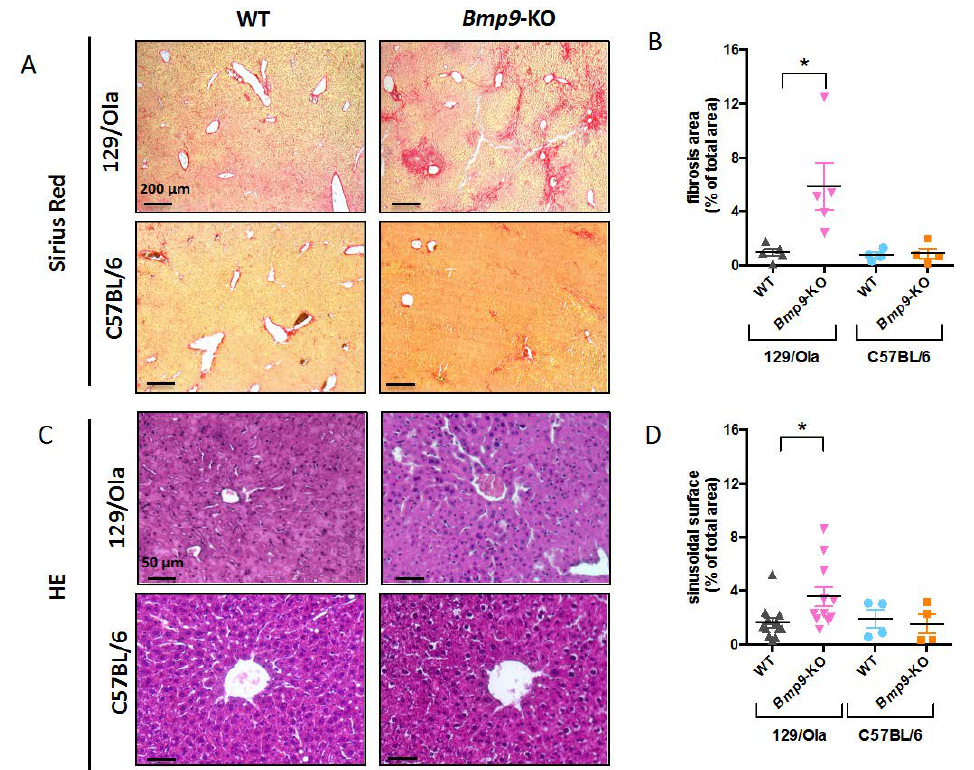
Figure 2. C57Bl/6 and 129/Ola Bmp9 -KO mice display different liver phenotypes. ( A ) Sirius red histochemical staining of the liver sections (5 µm) of WT and Bmp9 -KO mice from the 129/Ola and C57BL/6 strain. ( B ) Quantification of fibrotic surface in percentage of total area (n = 4 in each group, 5 images analyzed per mouse). Fibrotic areas appear in red and were quantified using the Axiovision software. ( C ) Hematoxylin and Eosin histochemical staining of liver sections (5 µm) from WT and Bmp9 -KO mice from 129/Ola and C57BL/6 strain. ( D ) Quantification of sinusoidal surface measured using Axiovision software and expressed as percentage of total area (n = 4–12 mice per group, 5 images analyzed per mouse). Central veins and arteries were excluded from this quantification. Data are expressed as mean ± standard error of the mean (SEM) of duplicate determinations from multiple samples. The Kruskal–Wallis test was used for all statistical analysis of this figure. * p < 0.05.